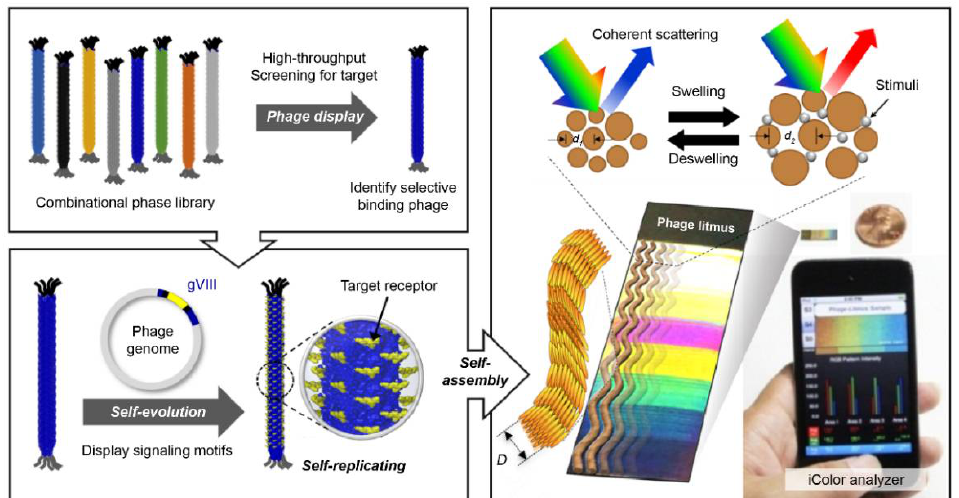
Figure 4. Colorimetric sensor system using an M13 bacteriophage as a functional biomaterial [109]. Peptide-based bioreceptor materials can secure various peptide sequences with desired functional groups using the phage display technology. Filamentous bacteriophage material with a scale less than 1 μm has approximately 2700 pairs of functional proteins on its surface. Hence, it can be used as a highly sensitive bioreceptor material. The synthesis process is based on internal DNA genetic information, and high-purity mass production is possible with simple genetic modifications. Phage units produced by bacteria have the same structure of a certain size and, thus have liquid crystal properties. A self-assembled structure can be produced using a bacteriophage as a unit, and it has liquid crystal properties; therefore, a color matrix can be produced by creating light scattering at regular distances formed by the structure. Based on the principle that phage self-assembled structures change the surface structure in response to external stimuli, a highly sensitive colorimetric sensor can be manufactured. This technique is referred to as the phage